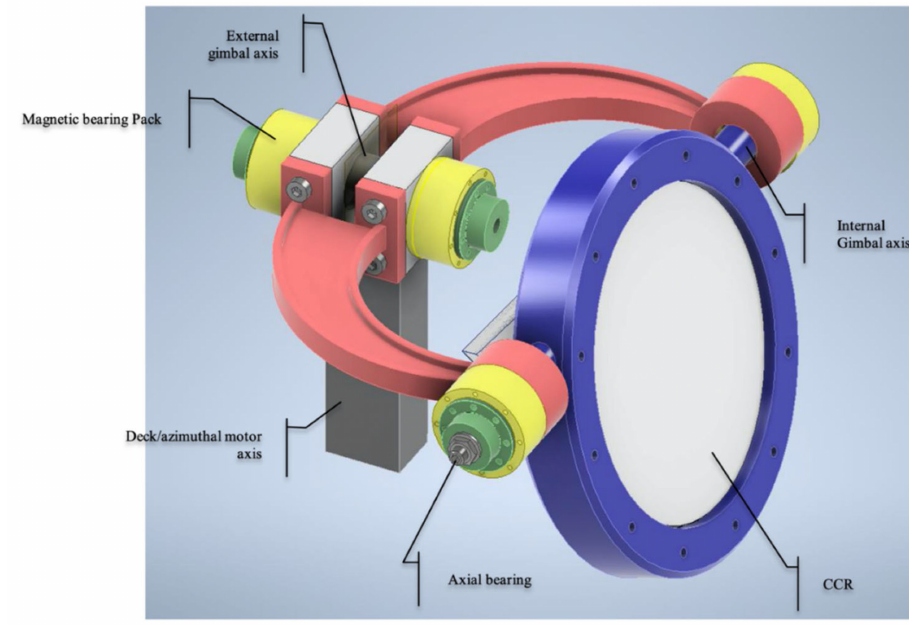
Figure 1. NGLR experiment cardan suspension